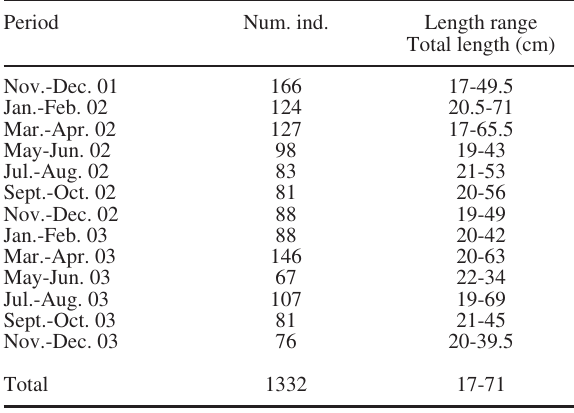
Table 1. – Sampling data on M. merluccius in the central Moroccan Atlantic.